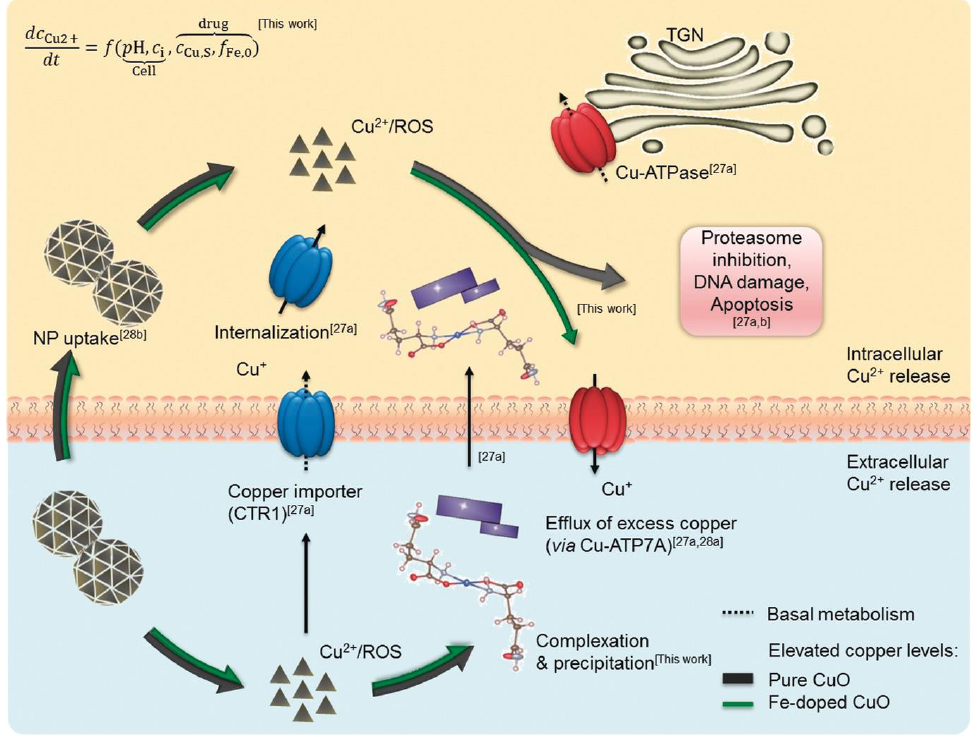
Figure 6. Copper homeostasis and regulatory mechanisms, including extra- and intracellular disso- lution of pure and Fe-doped CuO NPs.